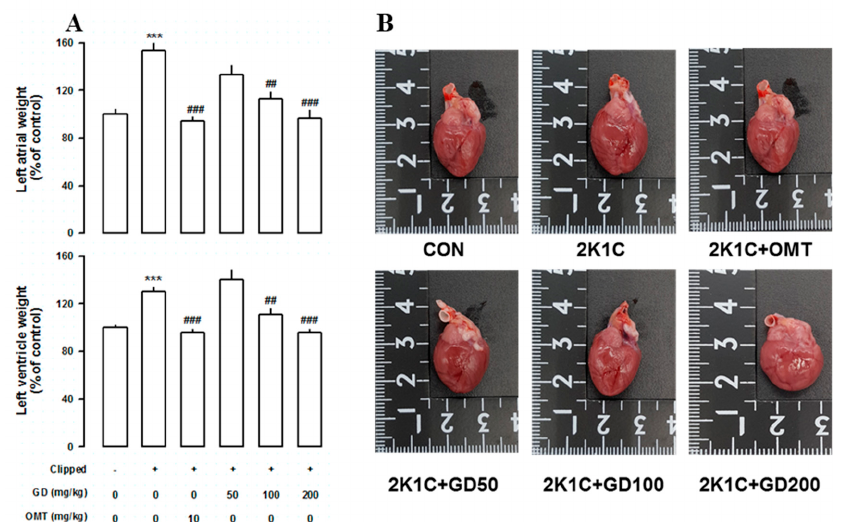
Figure 5. Effects of Gynura divaricata ( L .) DC (GD) on heart weight and shape. ( A ) Effects of GD on the left atrial and left ventricular weight (expressed as % of control); ( B ) Photographs of the heart size in each group. Each value represents the mean ± standard error ( n = 10 per group). *** p < 0.001 vs. CONT and ## p < 0.01, ### p < 0.001 vs. 2K1C.